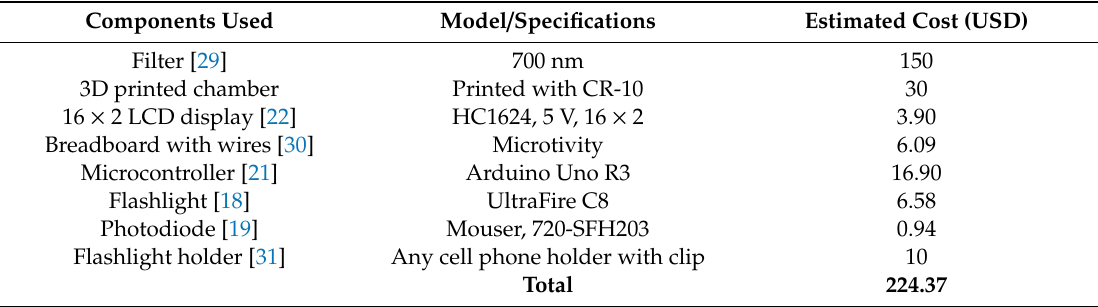
Table 1. List of major components required to construct the proposed